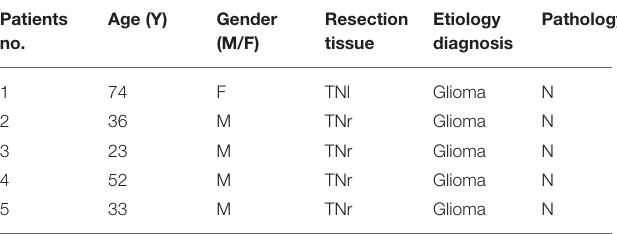
TABLE 2 | Clinical charactristic of the control patients. Patients